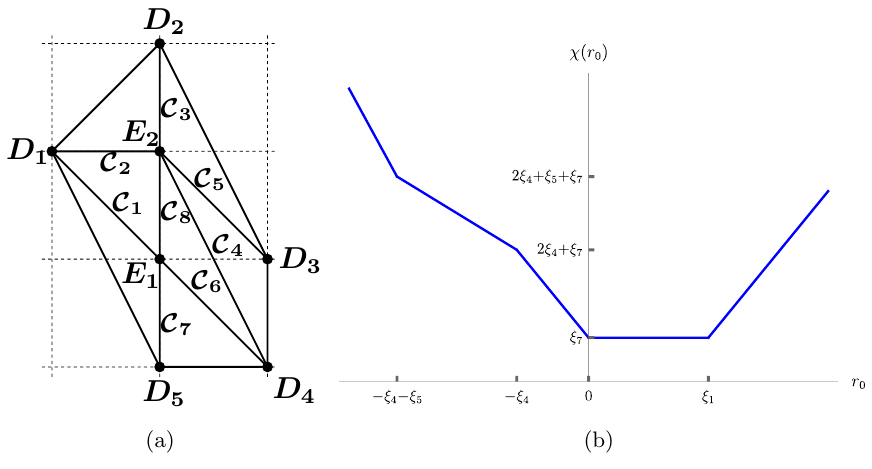
Figure 22 . Resolution (b) of the E 22 ; 1 2 singularity and its vertical